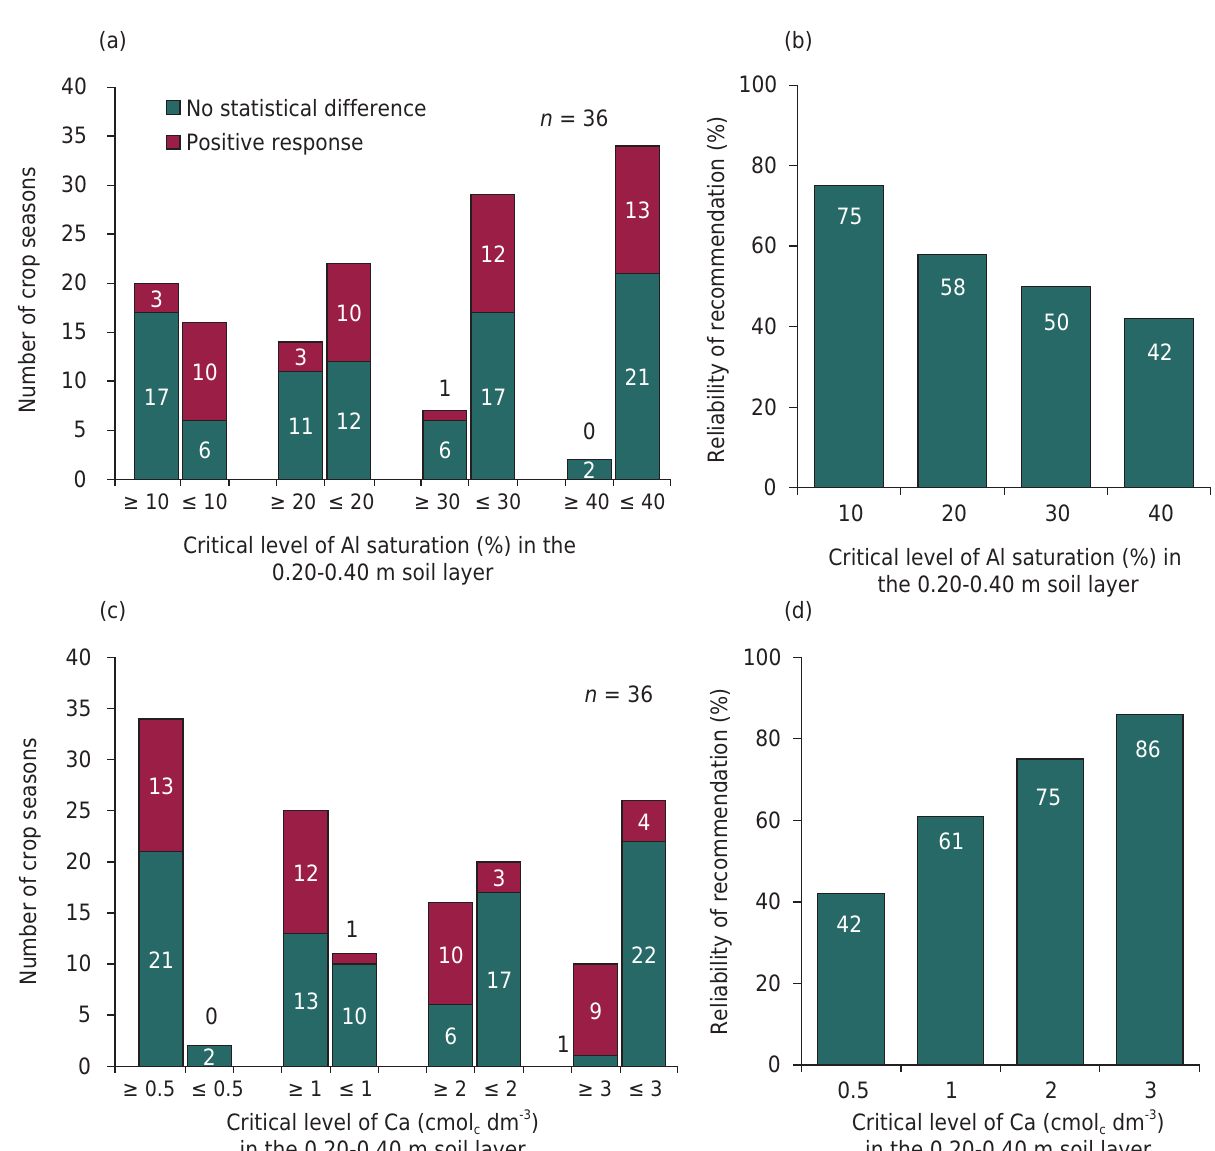
Figure 3. Response of grass crops (36 growing seasons) to gypsum application as a function of different critical Al saturation (a) and exchangeable Ca contents (c), and reliability of recommendations (b, d), in studies of subtropical soils under no-tillage in South of Brazil. Reliability was calculated from the number of growing seasons with a positive yield response to gypsum application when Al saturation and exchangeable Ca content (0.20-0.40 m soil layer) were above and below, respectively, the critical level, and the number of growing seasons in which no response to gypsum was observed when Al saturation and exchangeable Ca content (0.20-0.40 m soil layer) were above and below, respectively, the critical